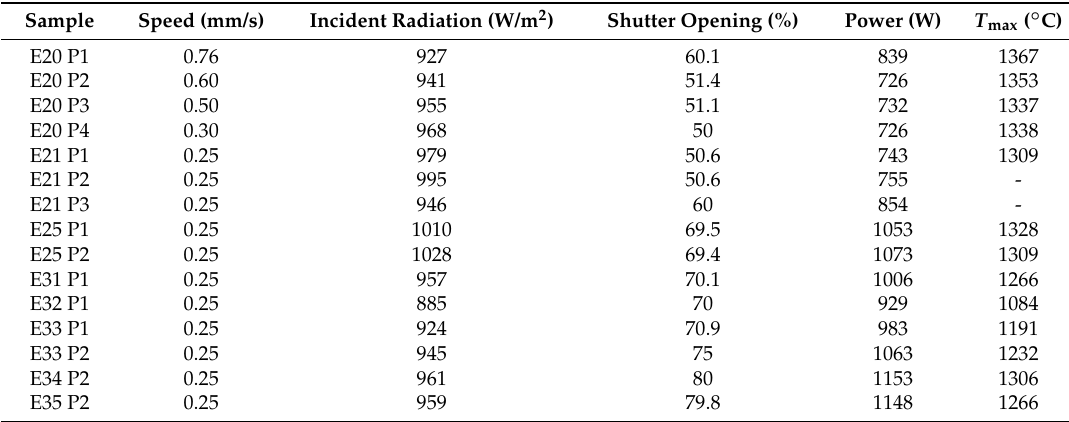
Table 8. Experimental conditions (continuation).